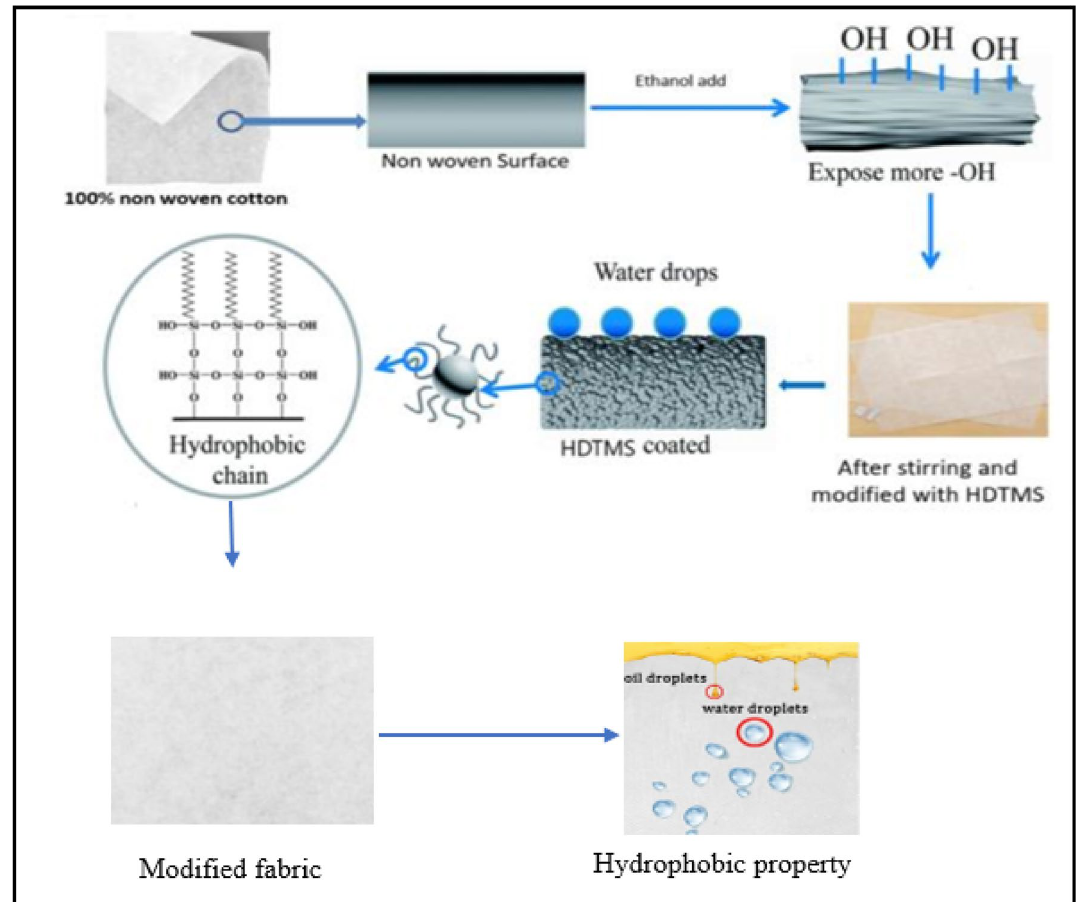
Fig. 1 Schematic illustration of preparation of hydrophobic surfaces on cotton